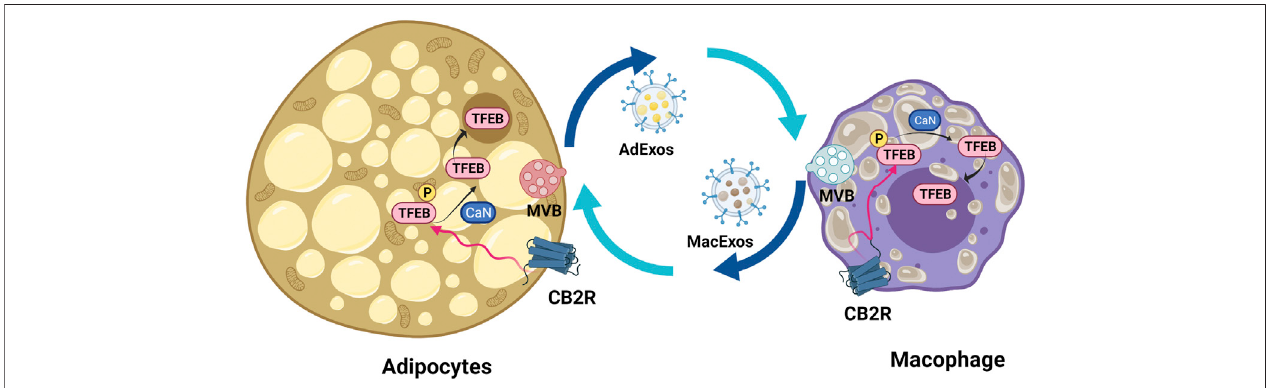
FIGURE 7 | Lipid droplet-loaded extracellular vesicle recycling between adipocyte and adipose tissue macrophage. Activation of CB2R results in TFEB translocation to nucleus and activation of autophagy and lysosome biogenesis, thereby improving the lipid cycle between adipocytes and macrophages. ApExos represents adipocyte exosomes and MacExos macrophage exosomes. The adipocyte multivesicular body (MVB) is represented with pink color and macrophage light blue